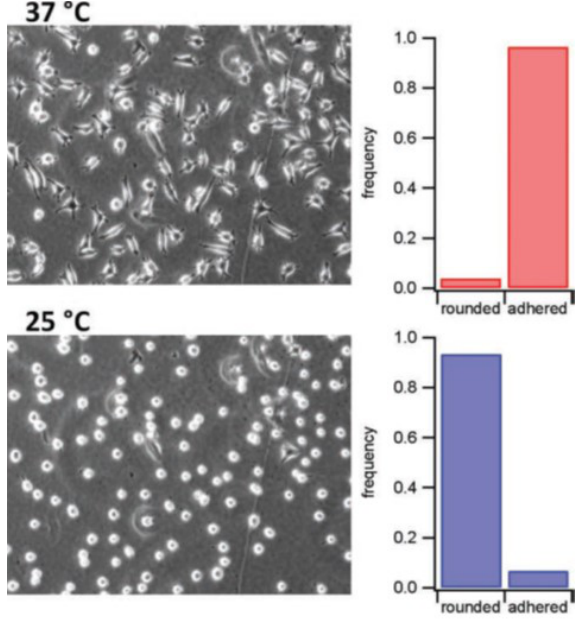
Figure 12. Phase contrast microscopy images of cells 48 h after incubation at 37 ◦ C (95% of the cells adhere) and 20 min after cooling the surface to 25 ◦ C (95% of the cells detach). Taken from